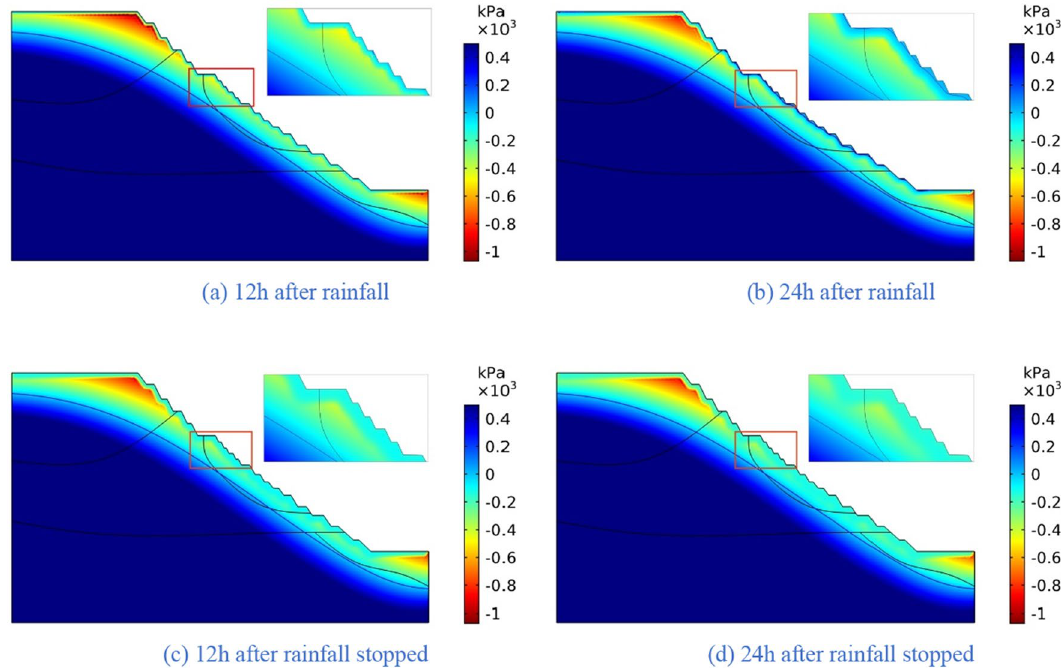
Figure 17. The pore-water pressure distribution (Scheme II).